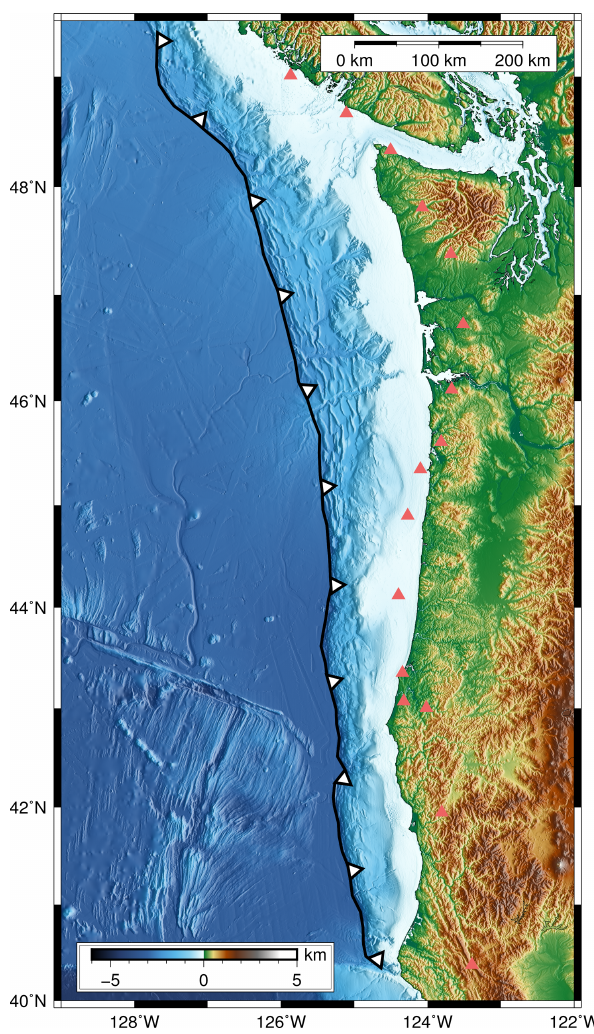
Figure 1. The domain of interest. The black line and white ar- rows depict the location of the trench; the orange triangles show the points used to drive the maximum subsidence. The reference point of the scale bar is assumed to be the bottom left corner of the